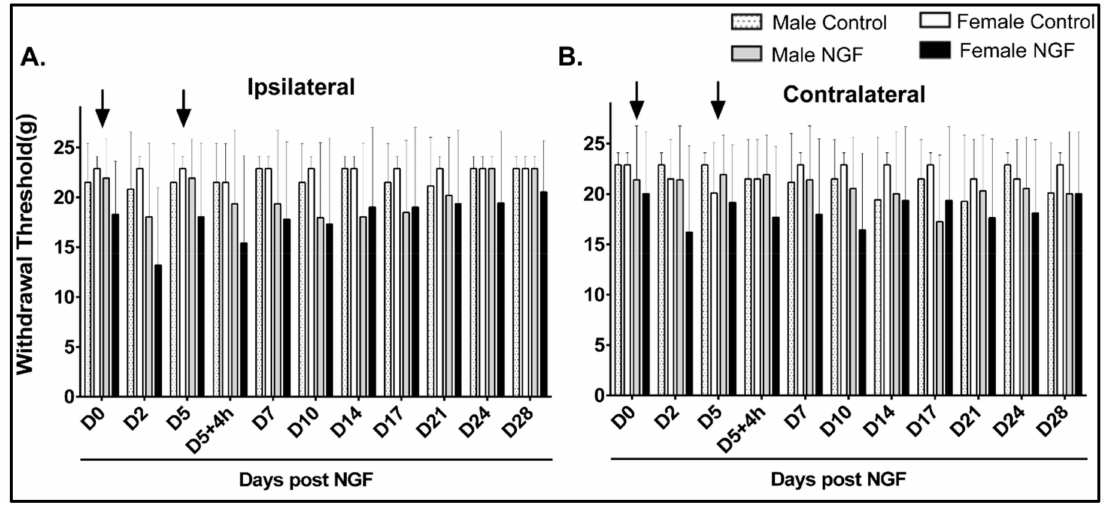
Figure 1. Behavioral responses to ipsilateral and contralateral cutaneous hindpaw mechanical stimuli were not altered during persistent low back pain in males and females. ( A , B ) Injections (arrows) of control (PBS) or NGF (0.8 µ M) were not associated with ipsilateral ( A ) or contralateral ( B ) hindpaw mechanical hypersensitivity. There were no significant alterations in withdrawal thresholds to cutaneous stimuli from von Frey filaments in male or female rats compared to baseline (D0). No significant differences were detected at D0 when comparing all groups. Data are reported as means ± SD and analyzed by two-way ANOVA with Bonferroni’s comparisons to baseline within a group or two-way ANOVA with Tukey’s multiple comparisons between groups for n =